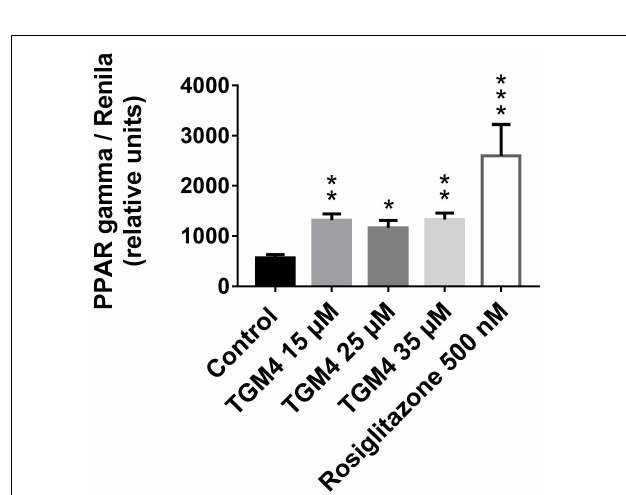
FIGURE 8 | Effect of different doses of TGM4 on the activity of PPAR- γ on PANC-1 cells. PANC-1 cells were treated with 15, 25, and 35 µ M of TGM4. PPAR- γ modulation was evaluated by the quantification of luciferase signal that is induced by PPAR- γ activity. Rosiglitazone (ROS) 500 nM was used as a positive control. The values were determined by luminescence measurement, and the mean ± SEM of 2 independent experiments with 3 replicates each expressed as a percentage with respect to the control were represented. The significance was determined by a t -test (* p < 0.05; ** p < 0.01; *** p < 0.001).